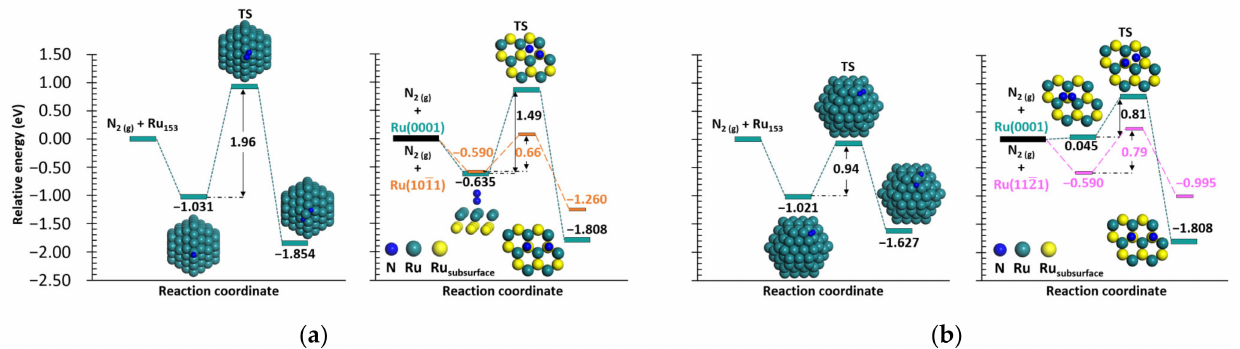
Figure 1. Calculated N 2 dissociation pathways ( a ) for the N 2 vertically adsorbed on the most stable top of a vertex atom of Ru 153 , on the top sites of Ru(0001) and Ru(1011), ( b ) for the N 2 horizontally adsorbed on the most stable 4F site of Ru 153 , on a 3F site of Ru(0001), and a 4F site of Ru(1121). Our calculated pathways for the N 2 dissociations on Ru 153 and Ru(0001) are shown in turquoise blue together with their respective configurations of the adsorbed, TS, and dissociated N 2 . Only the surface and subsurface Ru atoms are shown for the N 2 dissociation on Ru(0001). The pathways shown in orange and pink correspond only to the numeric values from references [27,35], respectively. The configurations corresponding to the adsorbed, TS, and dissociated N2 on the Ru(1011) and Ru(1121) can be found in references [27,35], respectively. The TS and energy barriers for the N 2 dissociation are also shown.